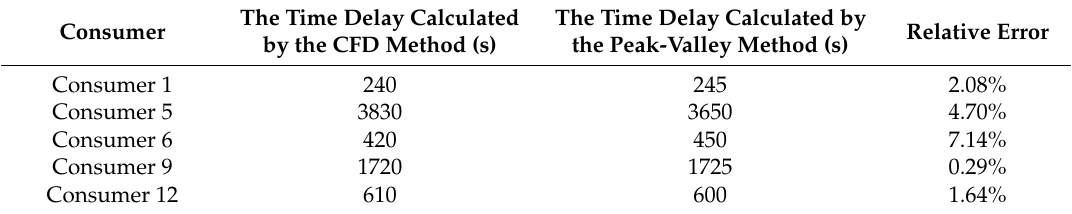
Table 5. Comparison of the CFD method with the peak-valley